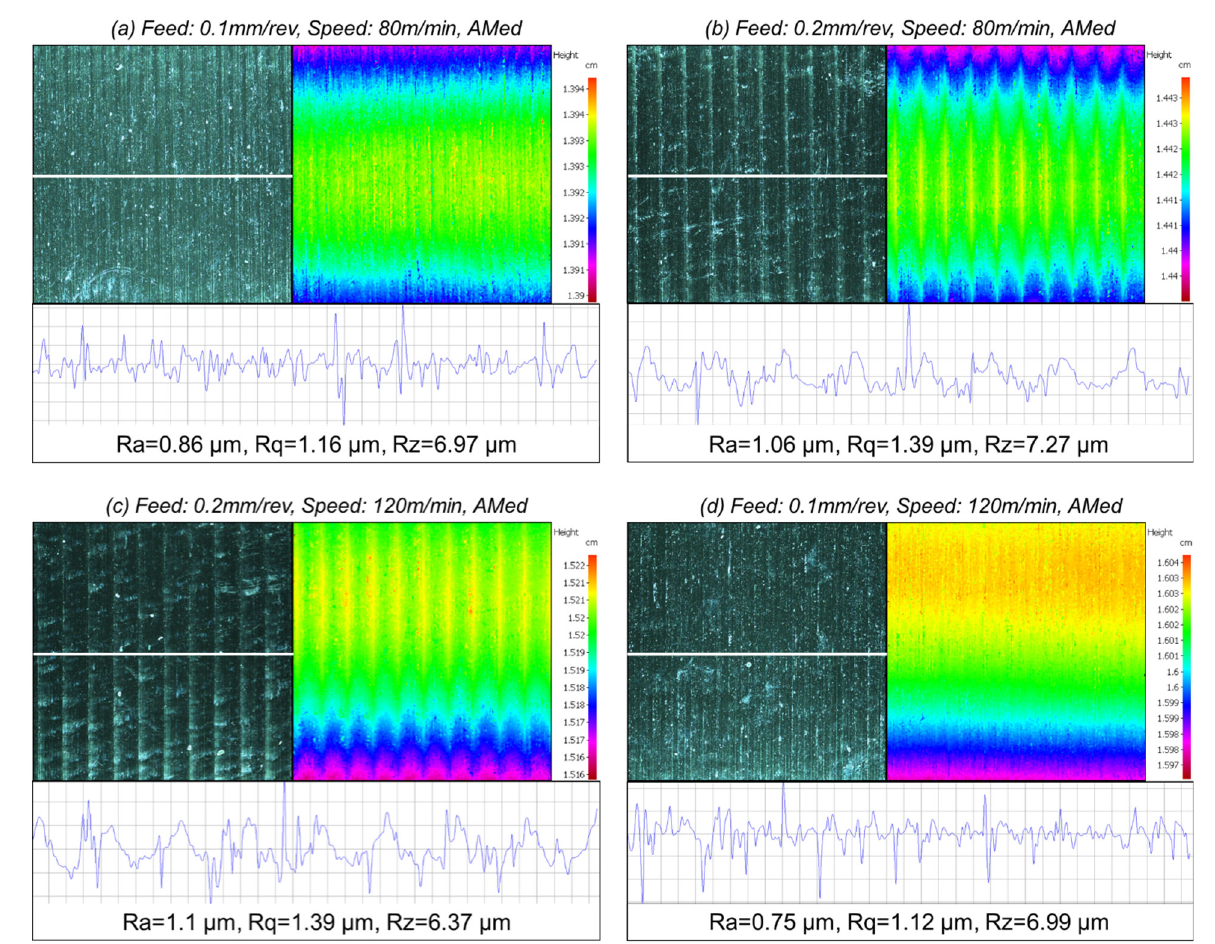
Figure 14. Profile of the machined surface of SLMed Ti6Al4V at the cutting depth of 0.5 mm, ( a ) feed rate: 0.1 mm/rev, speed: 80 m/min; ( b ) feed rate: 0.2 mm/rev, speed: 80 m/min; ( c ) feed rate: 0.2 mm/rev, speed: 120 m/min; ( d ) feed rate: 0.1 mm/rev, speed: 120 m/min.